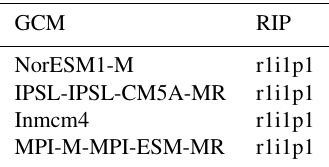
Table 2. List of the CMIP-5 GCMs included in the evaluation along with their RIP (realization–initialization–physics) code. All GCMs were first remapped to a common 2.0 degree regular longitude– latitude